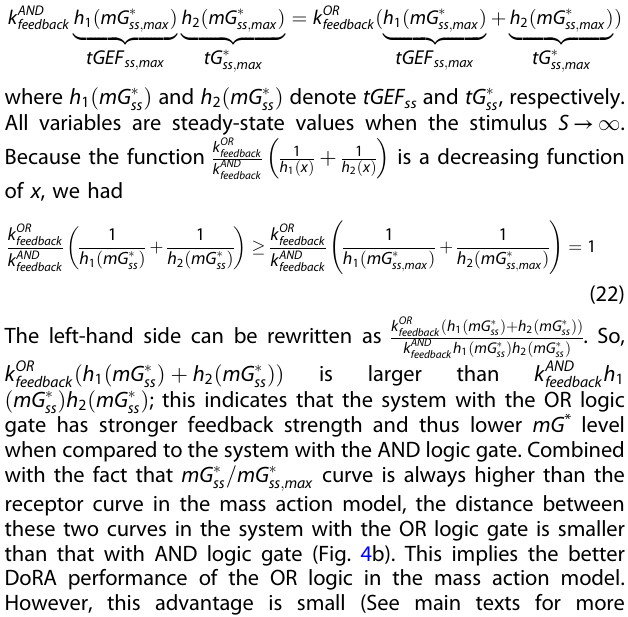
for the large y max . Since the large y max usually corresponds to the case that the normalized mGTPase curve is higher than the receptor curve, the negative sign of the ∂ ð y = y max Þ ∂ indicates the k feedback closer distance between two curves with increased feedback. Similarly, the small y max also suggests the closer distance between two curves with increased feedback, because at that time the normalized mGTPase curve is usually lower than the receptor curve. To now, we have fi nished the proof of Fig. 3c. The DoRA of tGTPase follows the same rule, and it can be proven using the same method shown in the previous section. Analysis for different logic gate The mass action model . In the mass action model, the OR logic gates show a little better DoRA behavior than AND logic gate. We used k AND and k OR to represent the negative feedback feedback feedback strength for the system with the AND logic gate and the system with the OR logic gate, respectively. The requirement about the same mG * activation level (i.e., mG (cid:1) ) indicates the same mGAP ss ; max level when the stimulus S → ∞ , because the mGEF is not affected by logic gates. Since the mGAP level is the same, the AND and OR logic gates show the same regulatory strength to the mGAP, leading to the following equation: